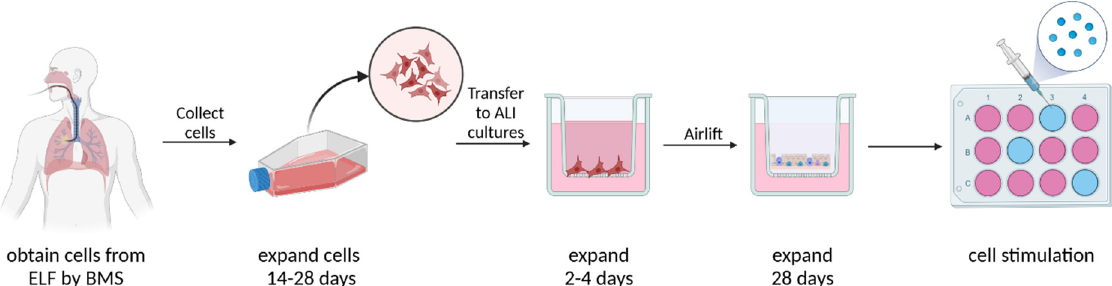
Figure 1. Culture method of HBE obtained by BMS. HBE cells were obtained from ELF by BMS and afterwards expanded in submerged cultures. After approximately 14–28 days, cells were transferred to tissue culture inserts for ALI culture. After reaching confluency after 2–4 days, cells were airlifted and maintained at ALI until a pseudostratified epithelium had developed. At day 28, cells were stimulated with pirfenidone, nintedanib or saracatinib. Finally, RNA, proteins and supernatants were collected. Created using BioRender.com.